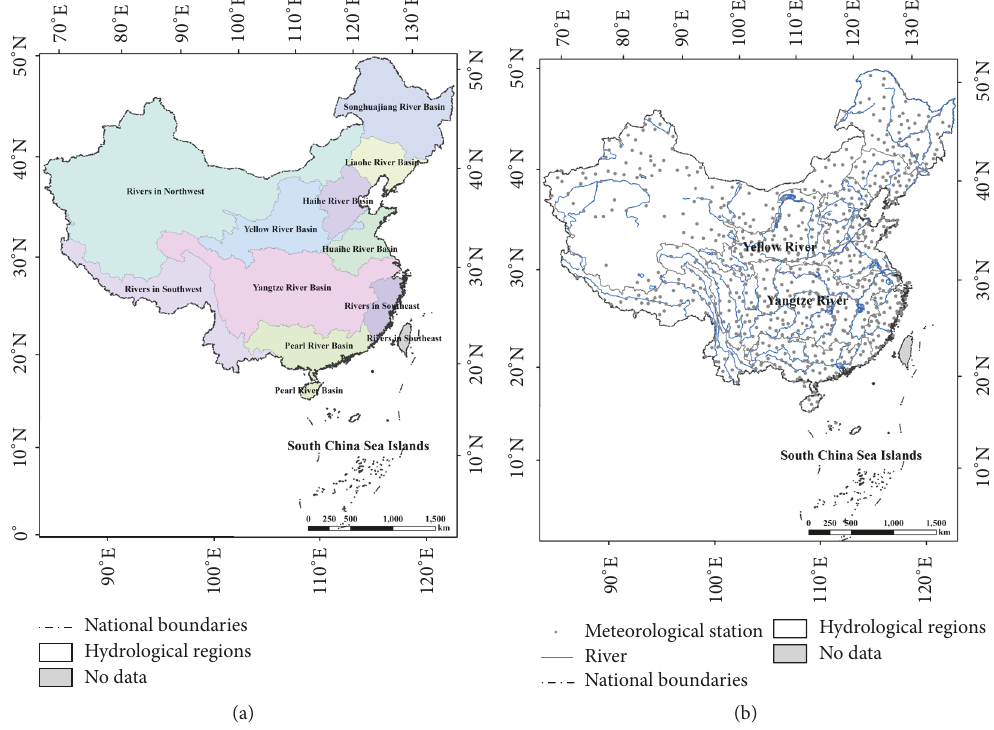
Figure 1: Ten hydrological regions (a) and geographical distribution of the 756 stations (b) in